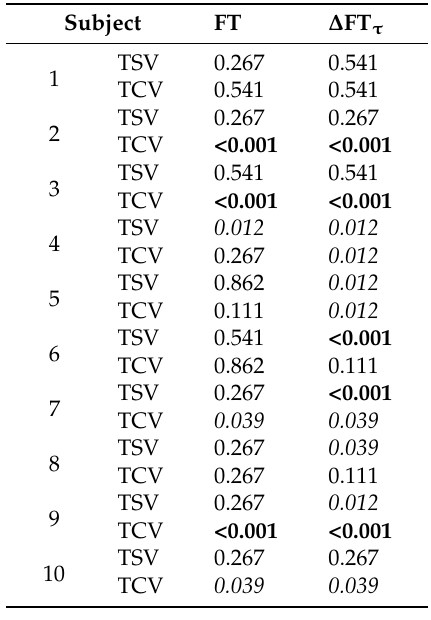
Table 3. p -values of K–S tests between both thermal sensation vote (TSV) and thermal comfort vote (TCV) series with respect to forehead temperature (FT) and deviation of forehead temperature with respect to previous time-step, ∆ FT τ , series. In bold, p -values significant with respect to α = 1%; and Italic those significant with respect to α = 5%.